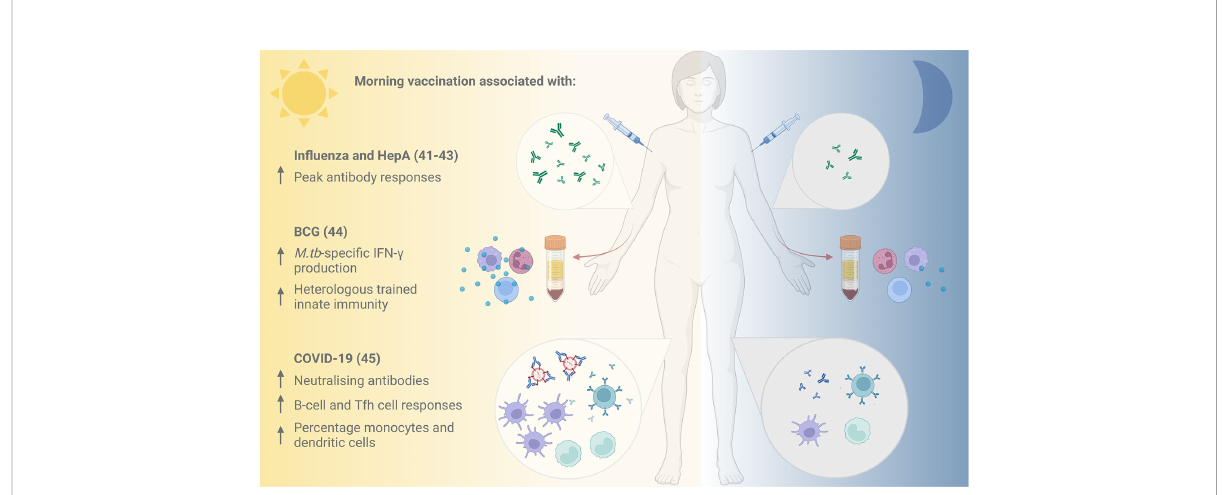
FIGURE 2 Evidence for improved vaccine responses following morning compared with afternoon vaccination. Vaccination against in fl uenza and hepatitis A in the morning has been associated with increased peak antibody responses (41), and morning in fl uenza vaccination with higher speci fi c antibody responses to the A/H1N1 in fl uenza strain (42, 43). Cells taken following morning BCG vaccination demonstrated elevated M.tb-speci fi c IFN- g production and stronger heterologous innate immune responses in vitro compared with those taken following afternoon vaccination (44). An inactivated COVID-19 vaccine induced higher neutralising antibody titres, improved B-cell and Tfh cell responses and higher percentages of monocytes and dendritic cells when administered in the morning (45). HepA, Hepatitis A; BCG, Bacille Calmette Gue ́ rin; M.tb, Mycobacterium tuberculosis ; IFN- g , interferon-gamma; Tfh, T follicular helper. Figure created with